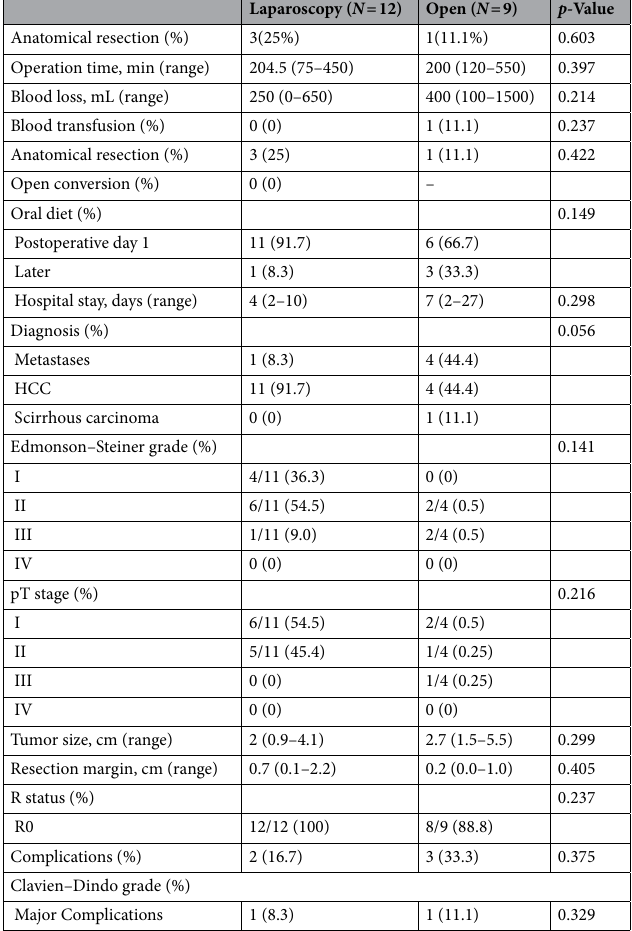
Table 2. Perioperative, postoperative, and pathological